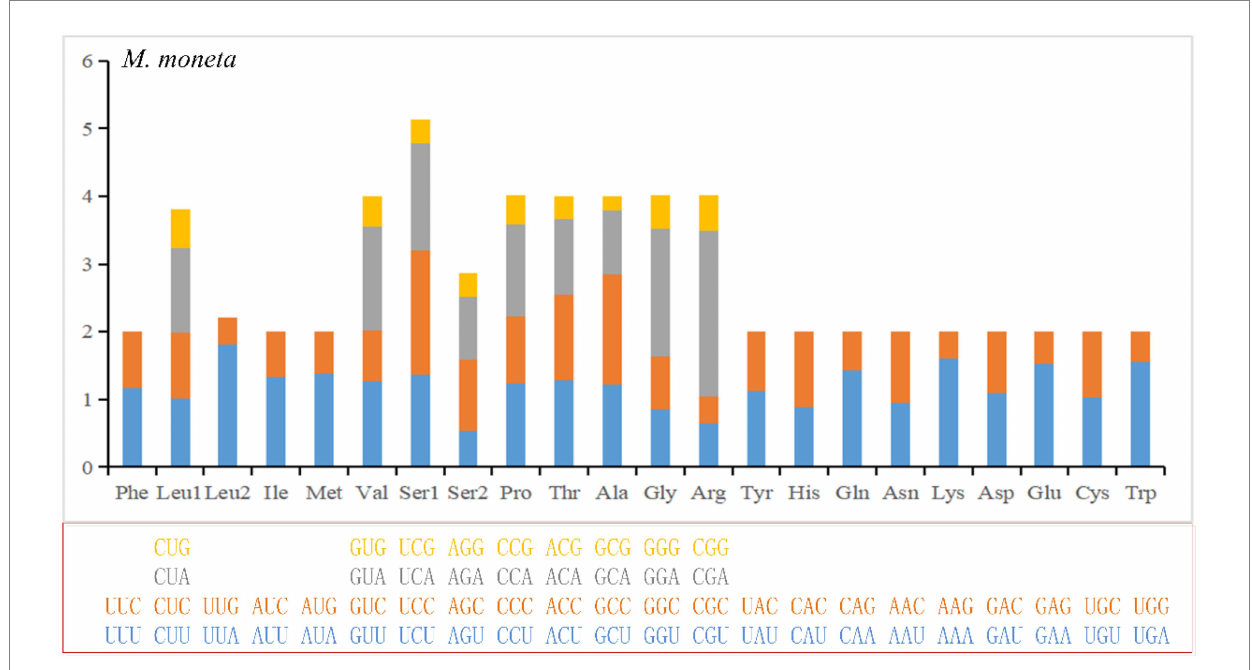
FIGURE 2 Relative Synonymoud Codon Usage (RSCU) of mitochondrial genomes for E. moneta. For other species, see Supplementary Figure S1.